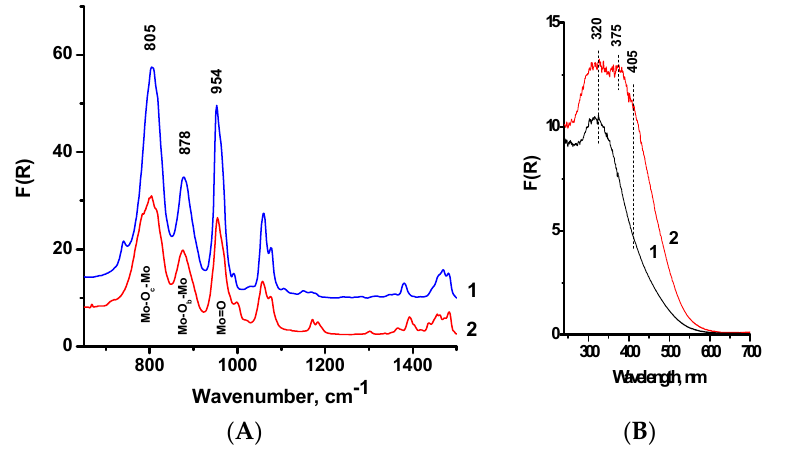
Figure 5. IR ( A ) and DR-UV-vis ( B ) spectra of Et 4 N-PMoV pristine (1) and after seven runs (2).